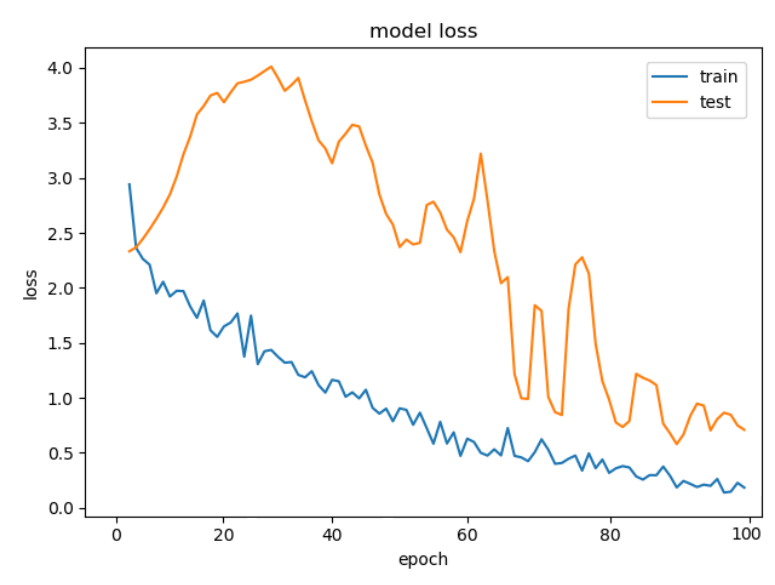
Figure 11. Training and test model loss of CNN-based handwritten Arabic digit recognition system by epochs are shown. The local dataset is separated to 80% training and 20% test